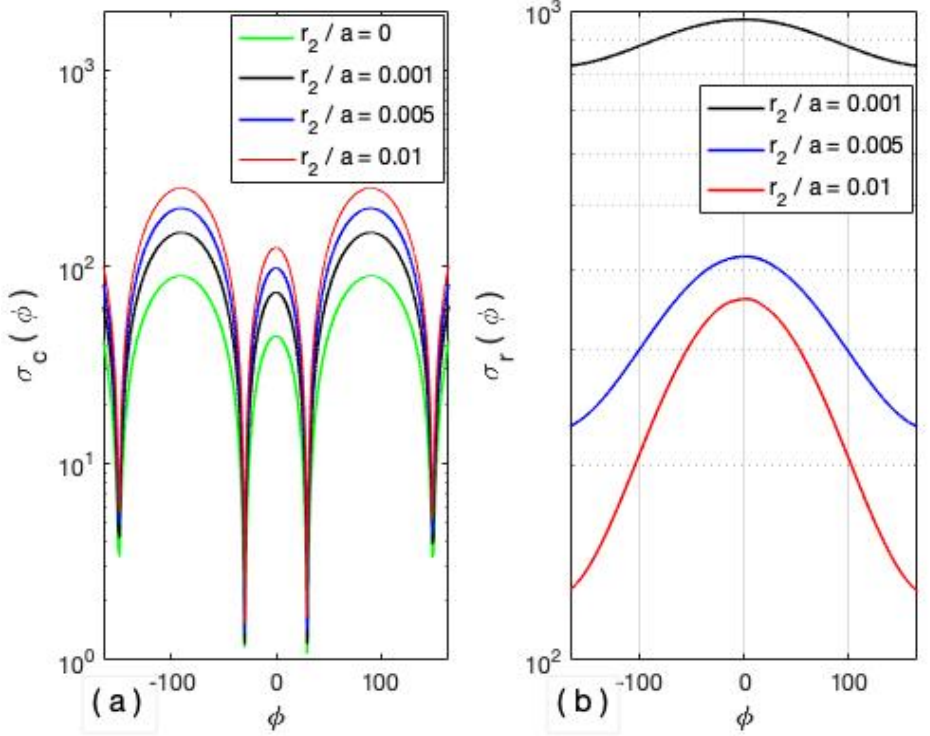
Figure 12. SCD distribution σ c ( φ ) and σ r ( φ ) under excitation of the TM 11 mode ( w / a = 0.25): ( a ) cavity; ( b ) rod.